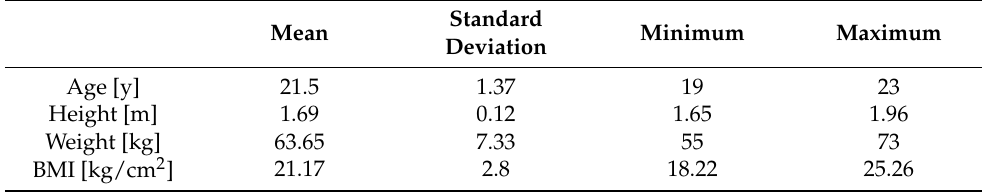
Table 1. Volunteer characteristics.